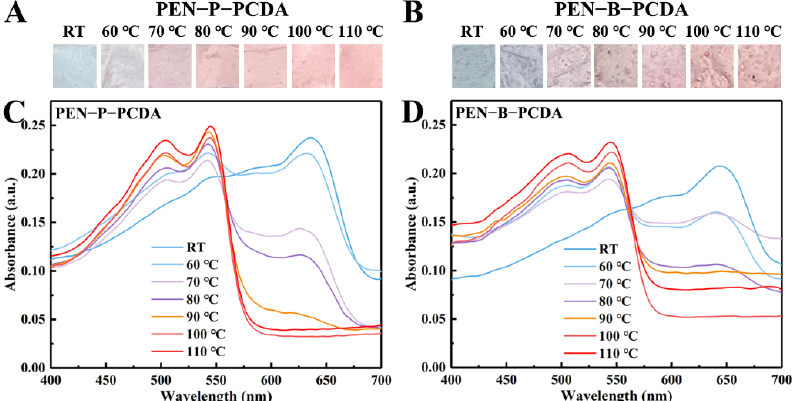
Figure 4. Photographic images and UV ‐ vis spectra of PEN − P − PCDA ( A , C ) and PEN − B − PCDA ( B , D ) after exposure to various temperatures.